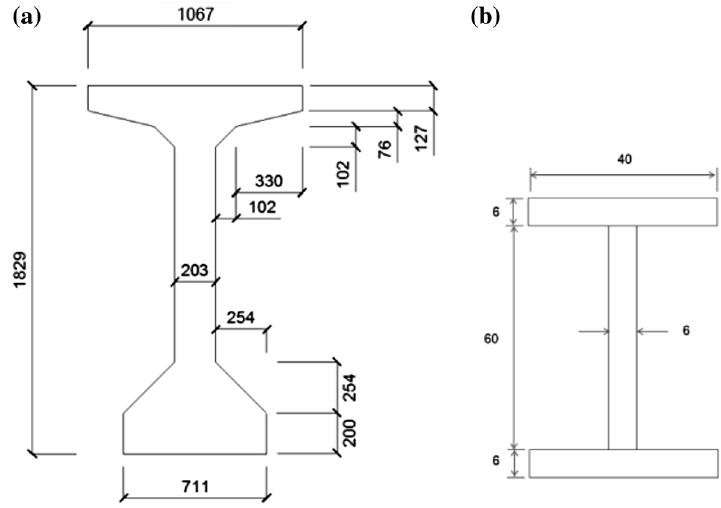
Fig. 1 Cross-section of the a AASHTO Type IV and b test beam (units: mm, not to scale).